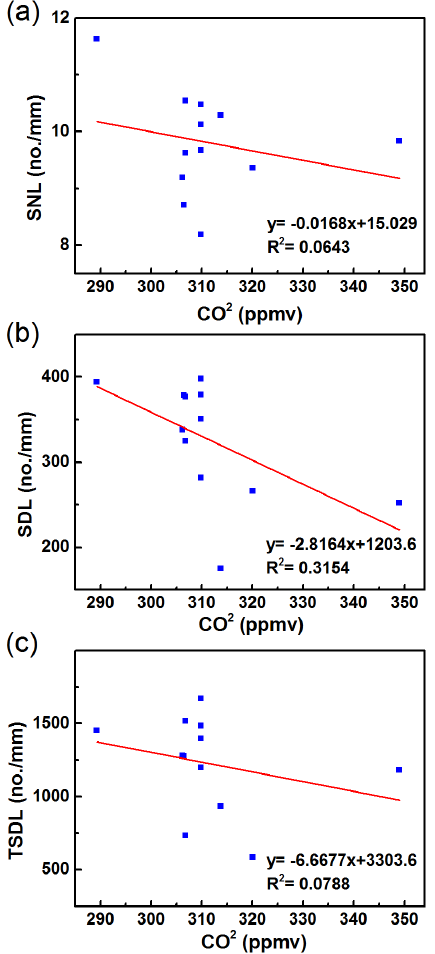
Figure 4. Correlation between SNL, SDL, and TSDL versus CO 2 concentration for modern Nageia motleyi . (a) Trends of SNL with CO 2 concentration for the adaxial surface. (b) Trends of SDL with CO 2 concentration for the adaxial surface. (c) Trends of TSDL with CO 2 concentration for the adaxial